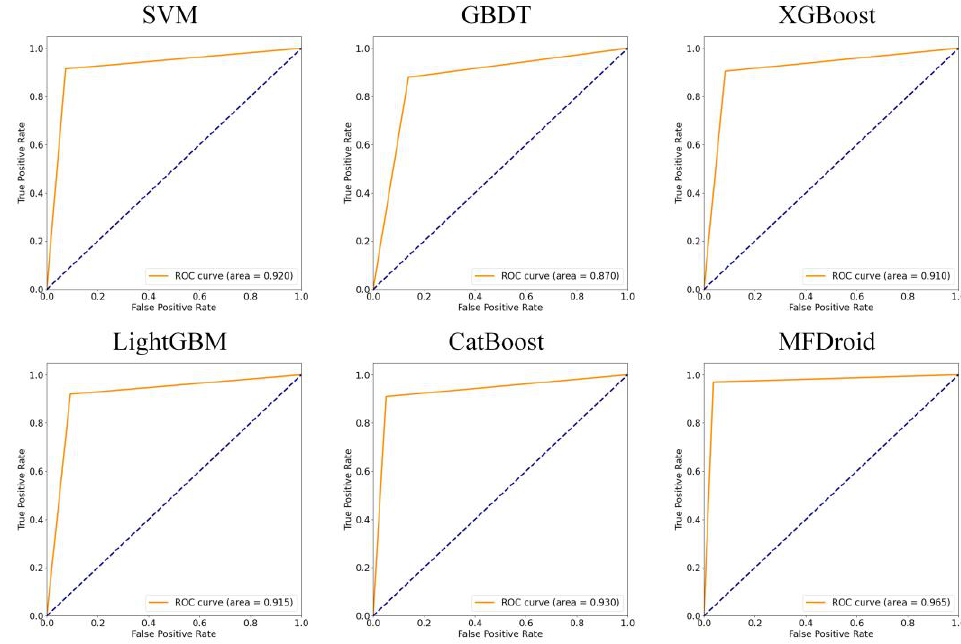
Figure 11. ROC curve of MFDroid and single classifier.